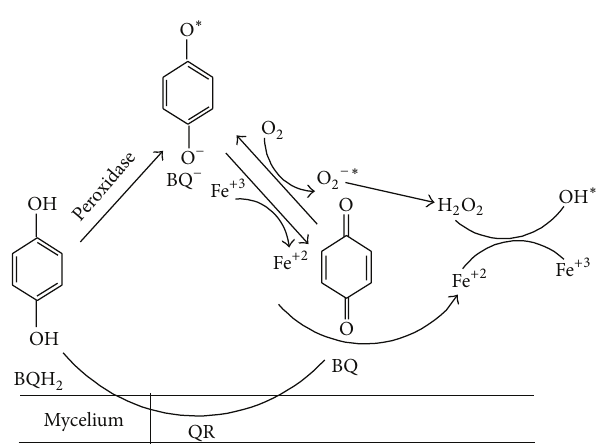
Figure 2: Reaction scheme involved in the production of hydroxyl radical by white rot fungi via quinone redox cycling [33]. 1,4- benzoquinone (BQ) is reduced by quinone reductase (QR) pro- ducing hydroquinone (BQH 2 ), which is oxidized by any of the lignin modifying enzymes to semiquinones ( BQ − ) . The production of superoxide anion radicals ( O 2− ) by BQ − autoxidation is mainly catalyzed by Fe 3+ that is reduced to Fe 2+ . Fenton’s reagent formation is accomplished by O 2 -dismutation to H 2 O 2